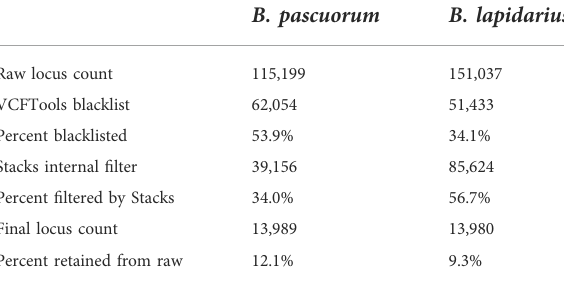
TABLE 3 Per species locus counts for loci generated and fi ltered by Stacks, and blacklisted by